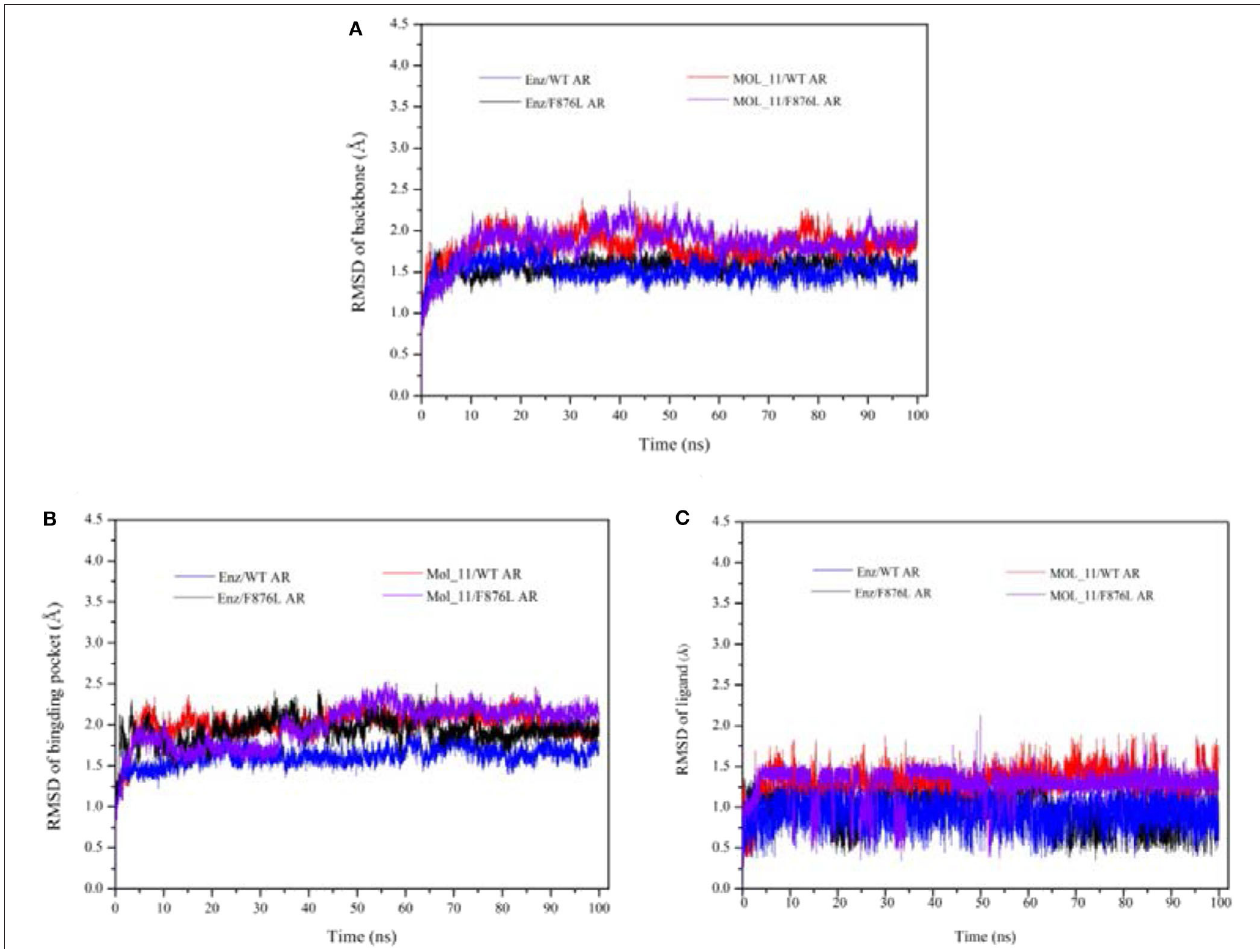
FIGURE 4 | RMSD value analysis chart. (A) is the RMSD of the acceptor skeleton atom; (B) is the RMSD of the amino acid residues within 5 Å of the active pocket; (C) is the RMSD of the ligand. Red indicates the MOL_11/WT AR system; purple indicates the MOL_11/F876L AR system; blue indicates the Enz/WT AR system; black indicates the Enz/F876L AR